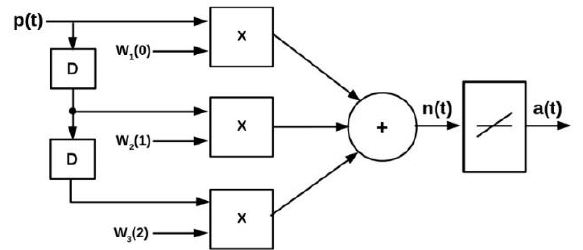
Figure 4. Block diagram of the ADALINE network with FIR architecture.